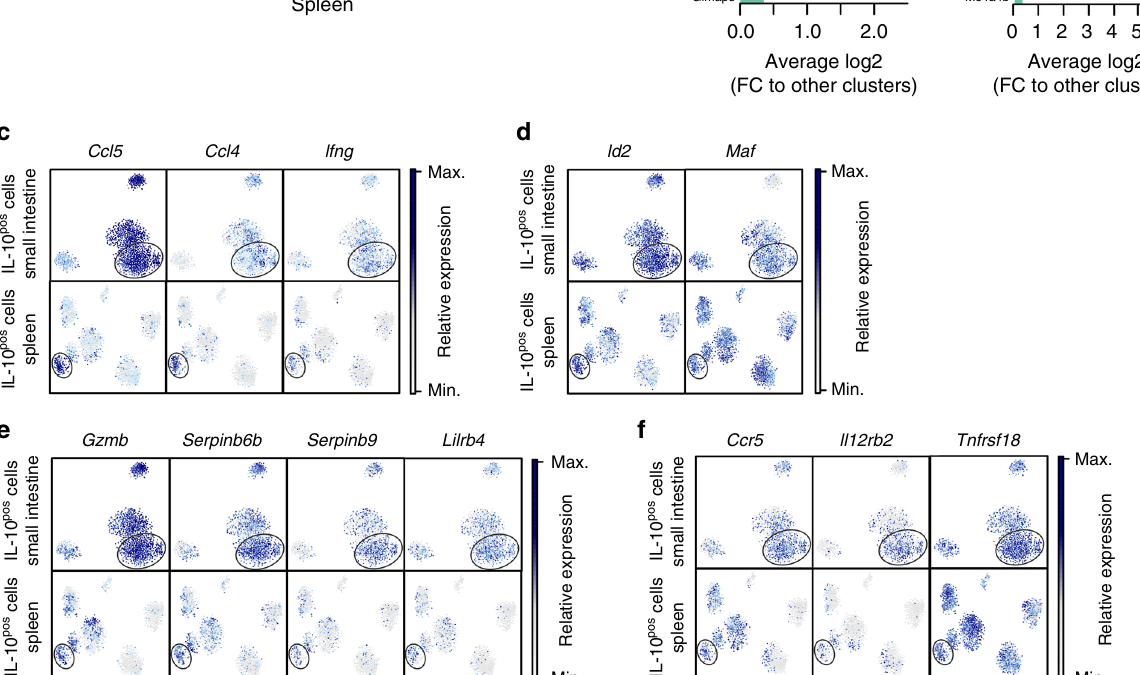
(Fig. 2b, e). Concurrent with the high expression of Gzmb , both SI